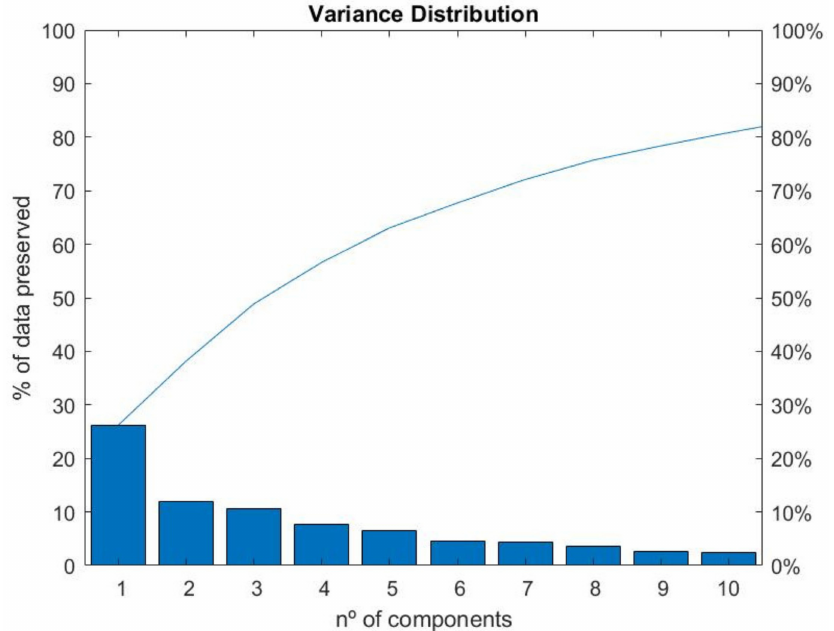
Figure 4. Pareto diagram to represent the percentage of data preserved in each Principal Component.